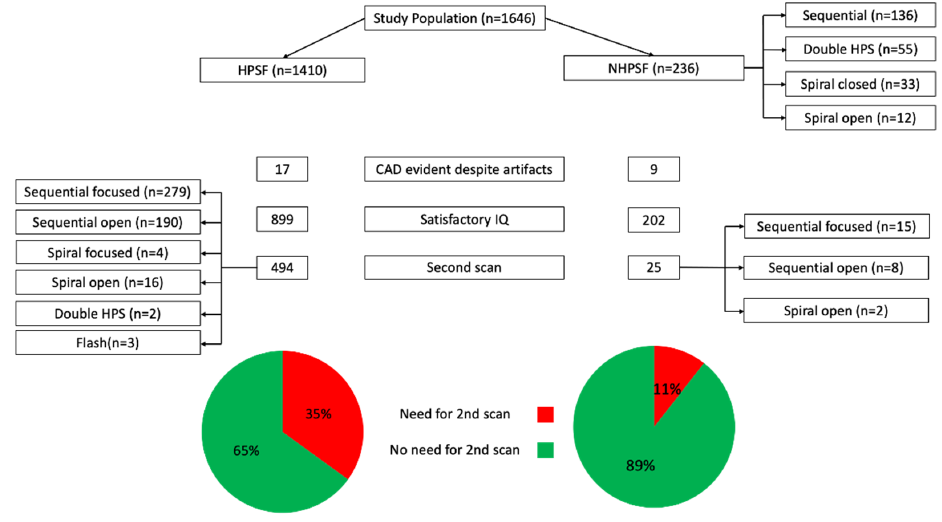
Figure 2. Flow chart of image acquisition. RS: retrospective spiral, SAS: prospective step-and-shoot, HPS: high-pitch spiral; HPSF: high-pitch spiral first; NHPSF: non-high-pitch spiral first; IQ: image quality; CAD: coronary artery disease.